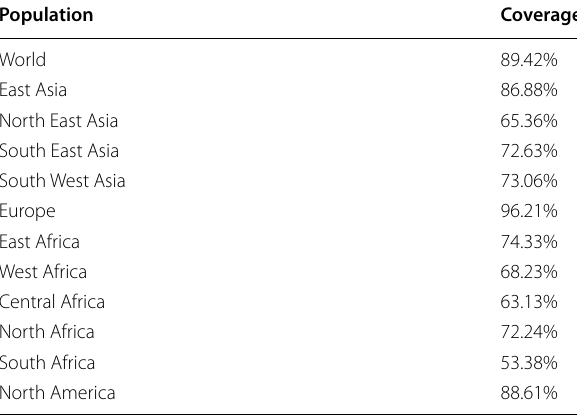
Table 3 Population coverage by selected MHC class-I